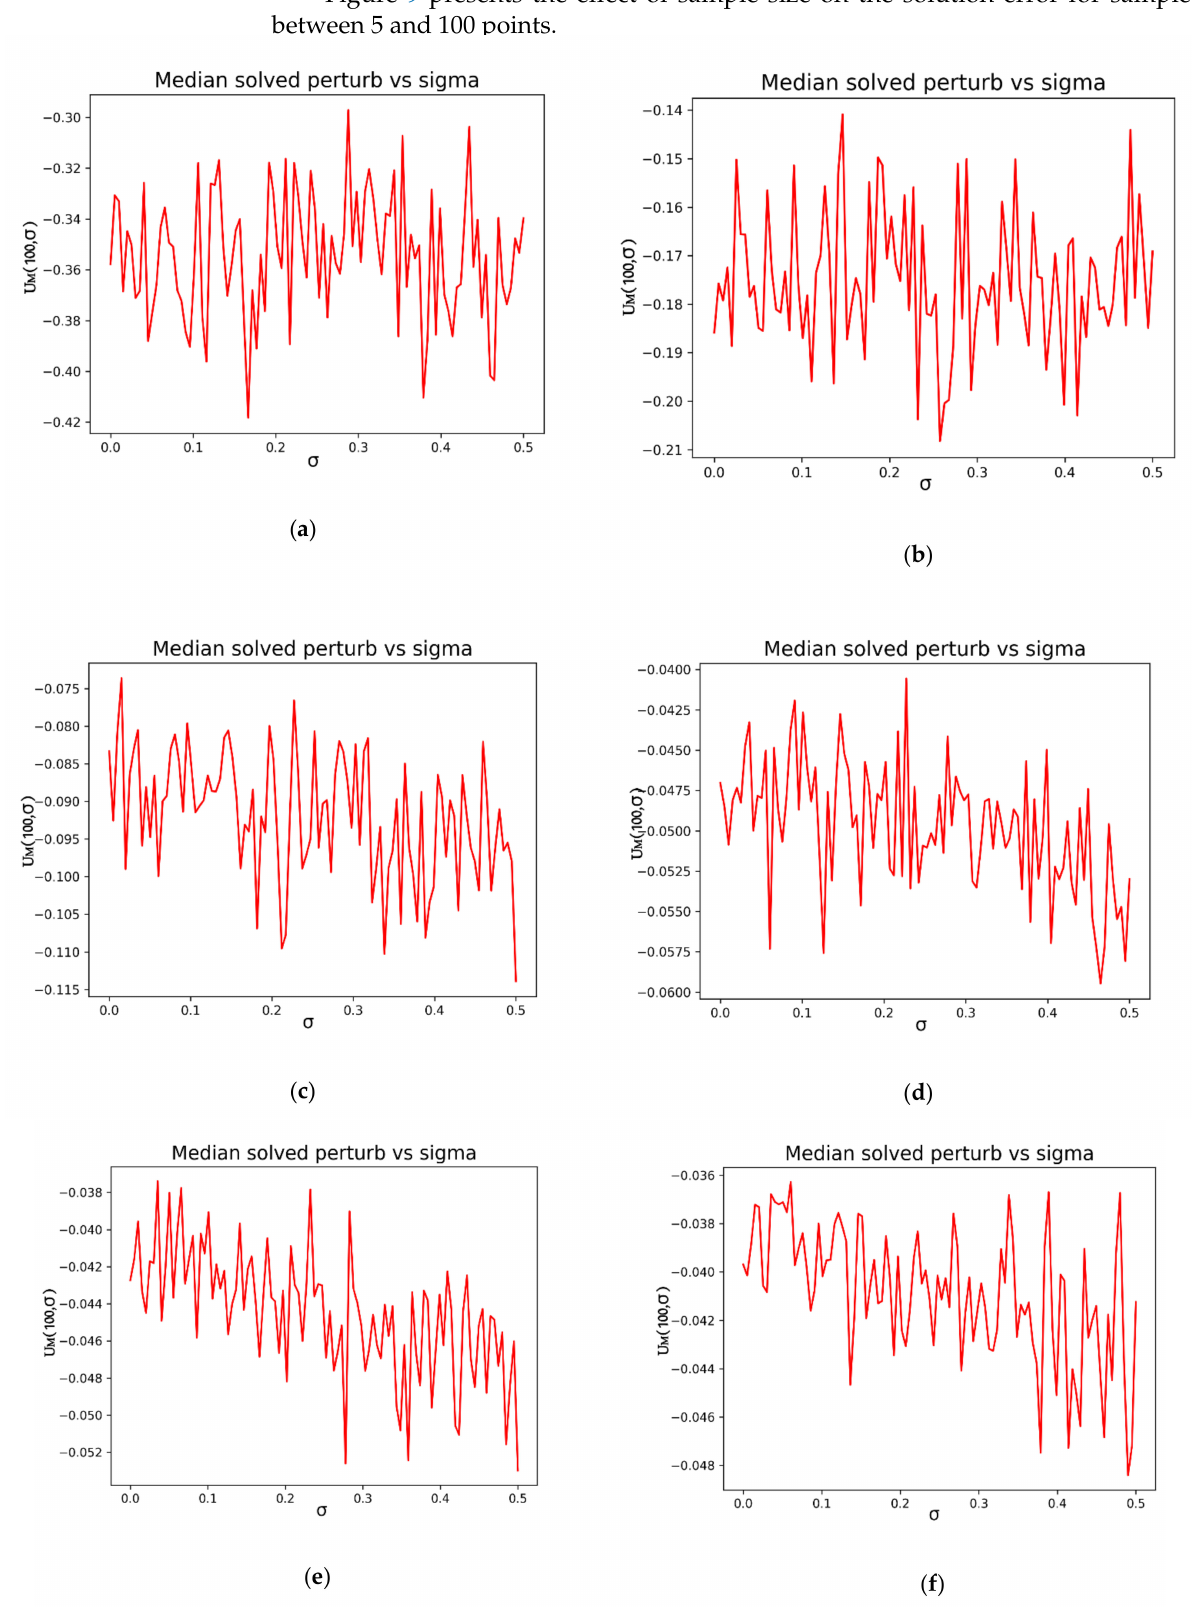
Figure 9. Effect on the parameter U M ( P , σ ) of different sample sizes for normal perturbation terms with standard deviations from 0 to 0.5: ( a ) P = 5; ( b ) P = 10; ( c ) P = 20; ( d ) P = 50; ( e ) P = 70; ( f ) P =